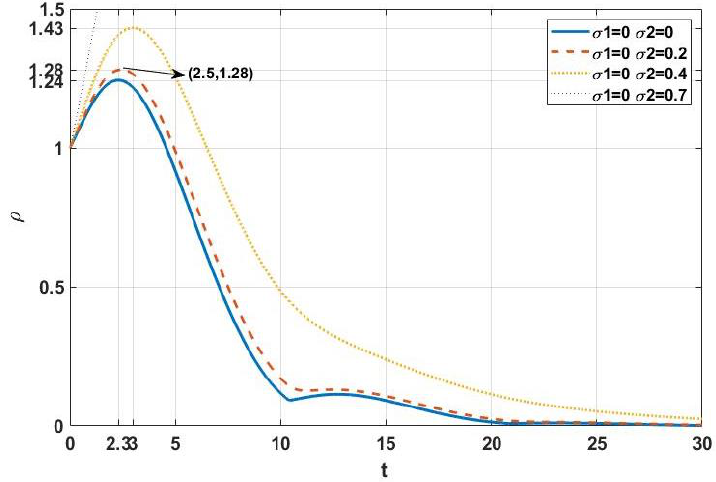
Figure 8. The root-mean-square amplification envelope of the system (7) only for predator